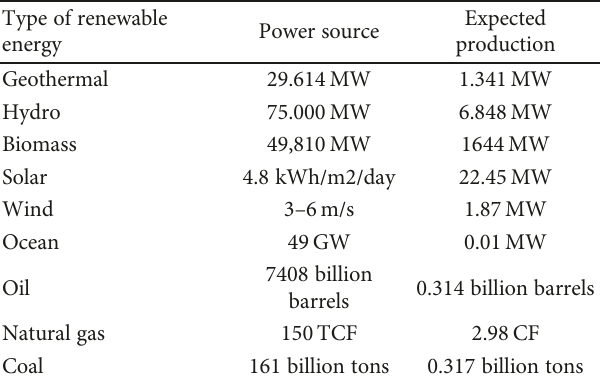
Table 1: Comparison of energy power potential.